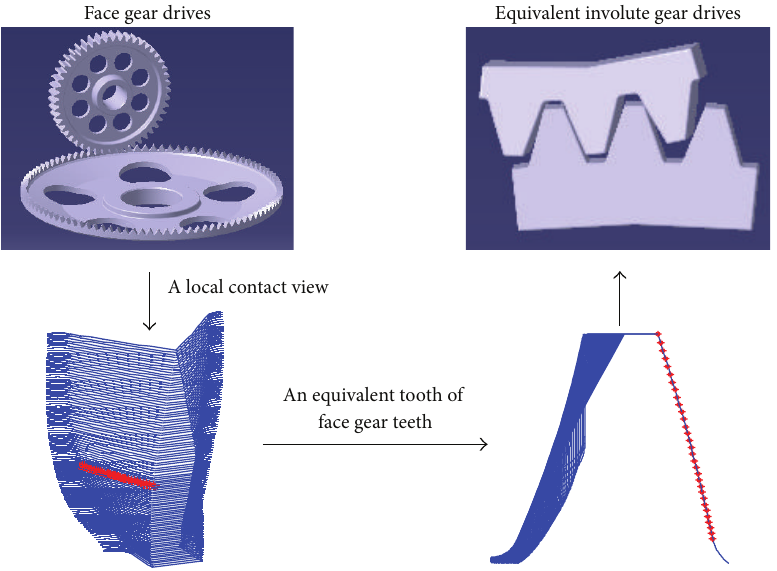
Figure 3: An evolution process of equivalent face gear